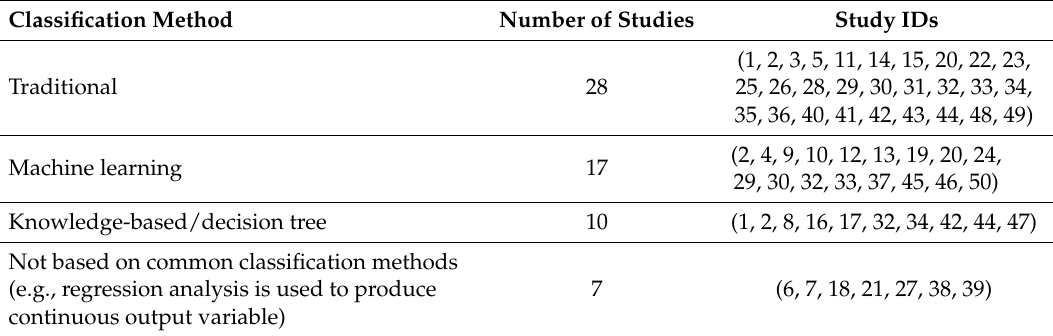
Table 4. Summary of methods used in land use-related